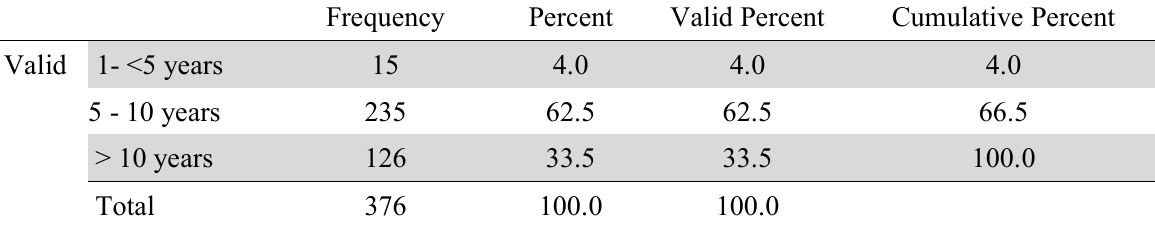
Overview of operating time of surveyed